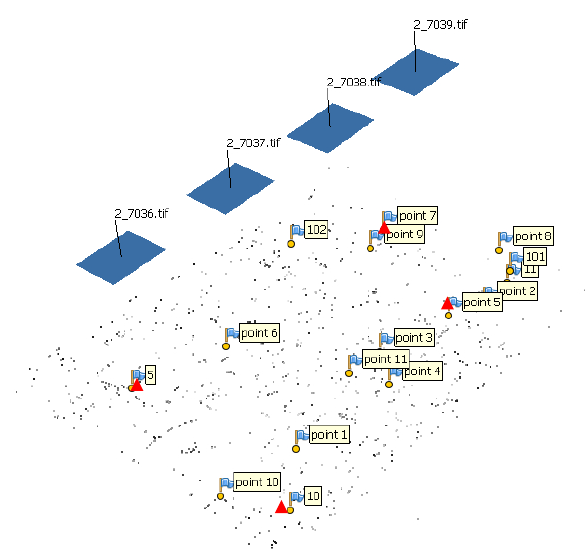
Figure 2. Positions of points and images in the ‘Test block:’ TP’s (points), GCP’s (red triangles), control points (yellow points with blue flag); and images (rectangles).